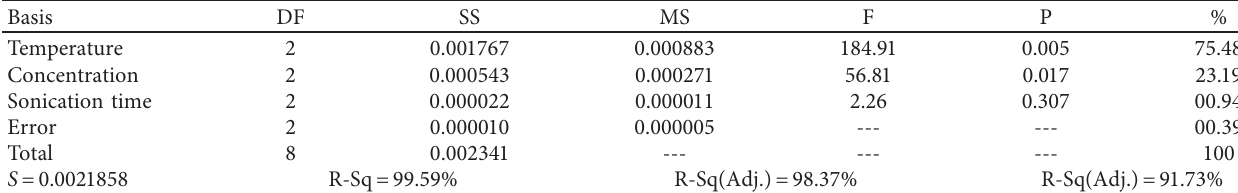
Table 6: Variance analysis for thermal conductivity (ball-milled